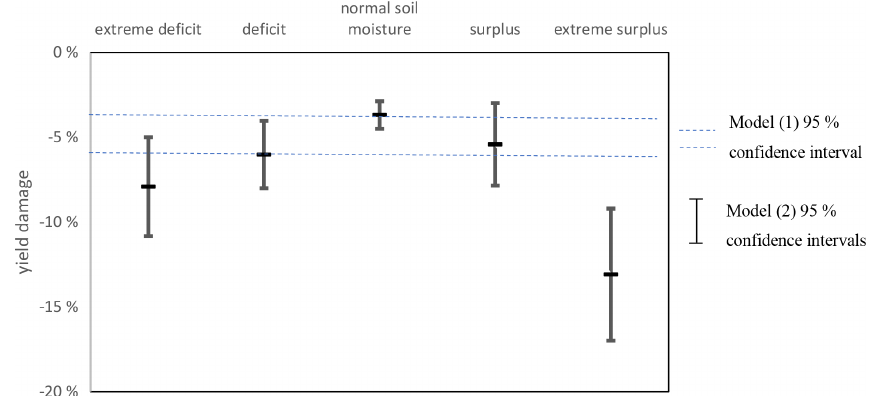
Figure 5. Estimated damage to corn yield from additional 10 dday above 29 ◦ C and no change in seasonal mean soil moisture.